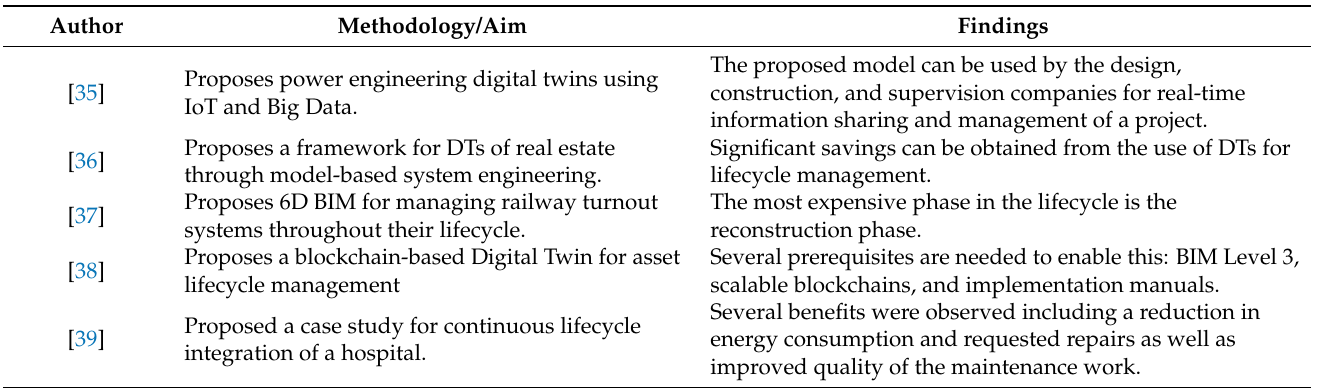
Table 3. Digital Twin for Lifecycle